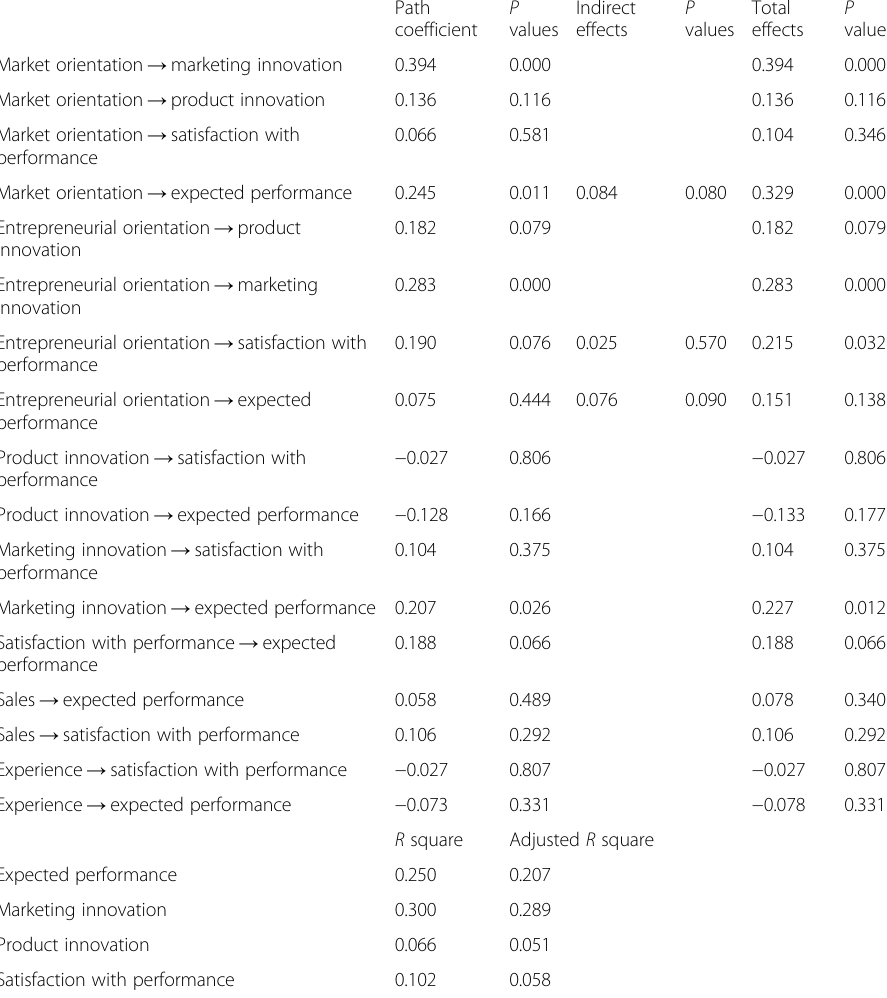
Table 7 Results of path analysis